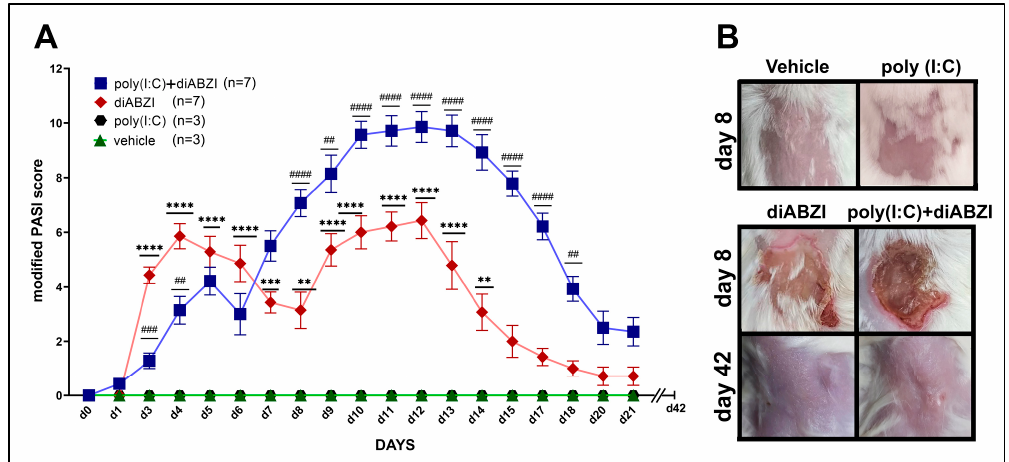
Figure 2. PASI scores at the site of injection. ( A ) Kinetics and severity of diABZI-induced skin inflammation in mice with or without poly (I:C) pre-treatment. BALB/cJ female mice injected with diABZI on a shaved back were evaluated for erythema, scaling, and induration. Each criterion was scored from 0–4, with 0 = no change and 1–4 corresponding with increasing severity. A cumulative modified PASI score was calculated. Data points are mean ± SEM for mice in each group. The number ( n ) of mice in each group is shown in parentheses. Differences between groups were determined using two-way ANOVA followed by Sidak’s post-test for multiple comparisons. Significant differences between diABZI and vehicle controls (*) and between diABZI and poly (I:C)+diABZI (#) are shown., **, ##; p < 0.01, ***, ###; p < 0.001, ****, ####; p < 0.0001 . ( B ) Representative images of the lesions on day 8 for vehicle and poly (I:C) control mice and on days 8 and 42 for diABZI and poly (I:C)+diABZI mice.